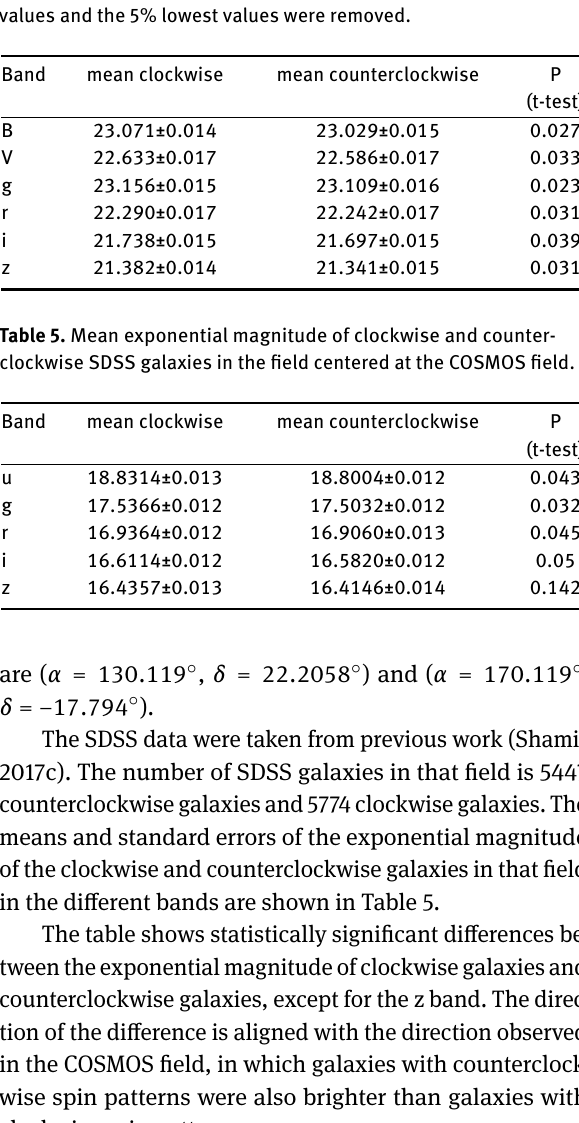
Table 2. Means and standard error of the means of the differences between the magnitude of clockwise galaxies and counterclockwise galaxies in COSMOS when the galaxies were mirrored.